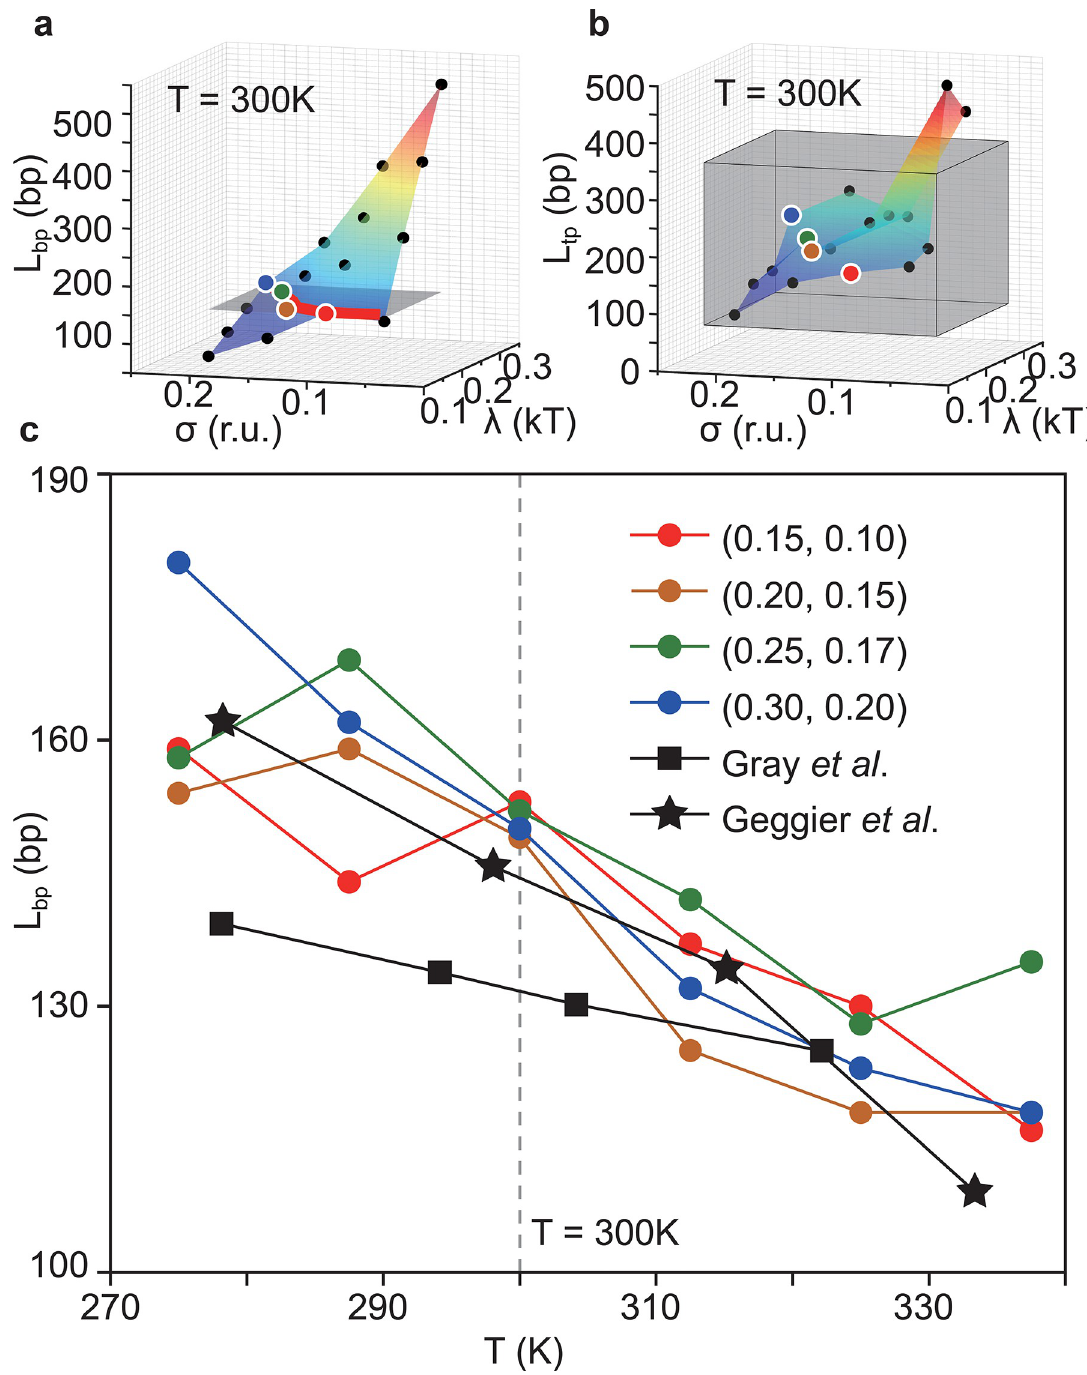
Fig 2. DNA Persistence Length and Parametrization. (a)(b) These figures show how persistence lengths depend on the strength of the energy interactions, λ , and the scale of structural fluctuations, σ . The bending persistence length is shown in panel (a), while the twisting persistence length is shown in panel (b). The σ is in reduced units (r.u.) which is 0.241 nm as explained in the Appendix A in S1 Document. Dots indicate the data points obtained by simulation; colored surfaces indicate their linear interpolation. The horizontal gray plane in (a) shows the experimentally determined bending persistence length of DNA, 150bp. This persistence length is set as the target for the optimization of the parameters. The red line indicates the intersection of the two surfaces, where our model meets the target persistence length value. Similarly, the gray box in (b) is the experimentally determined twisting persistence length, 75-360bp, our target in this case. (c) The figure shows the temperature dependence of bending persistence length. The four colored lines show results obtained using the WEChroM model. Black lines show experimental results published by Gray et al. [61] and Geggier et al. [62], respectively. As shown, the proposed model agrees well with the experimental observations for several couples of parameters ( λ , σ ).